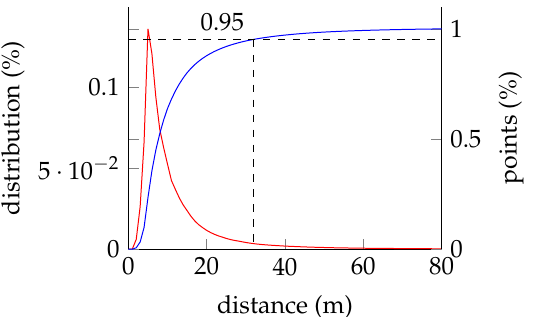
Figure 6. Depth distribution for the SemanticKITTI dataset. A total of 95% of all points are closer than